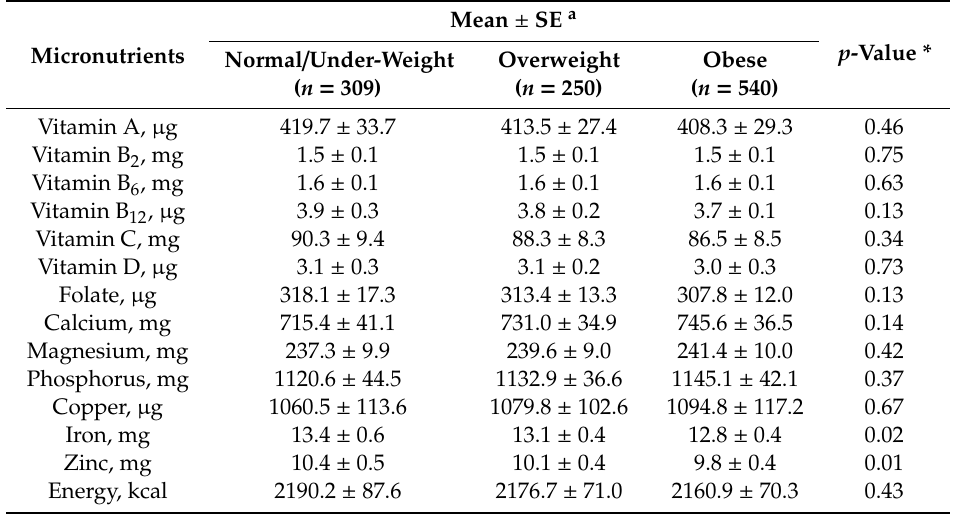
Table 4. Estimated daily usual micronutrient intakes from foods, and micronutrient density among